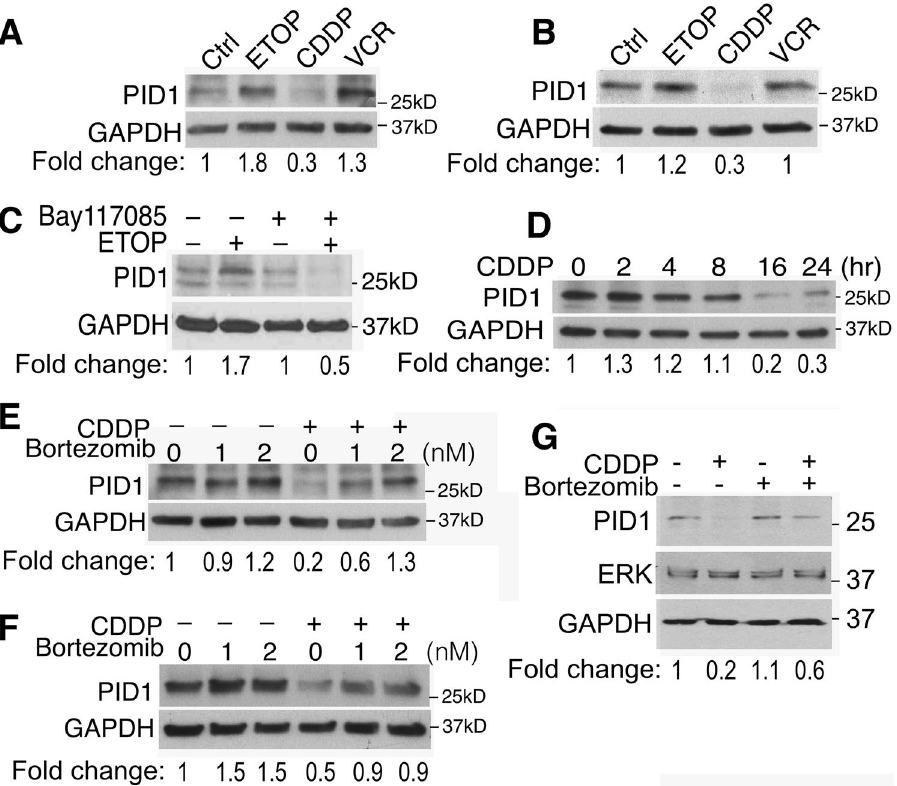
Figure 5. PID1 protein is differentially regulated by etoposide and cisplatin. SDS-PAGE and western blotting of tumor cell lysates for PID1 protein. ( A , B ) PID1 protein is increased by etoposide and vincristine but decreased by cisplatin: LN229 ( A ) or U87 ( B ) GBM cells were plated overnight in 6-well plates (4 × 10 5 cells/well). Cells were then treated with vehicle, cisplatin (5 µ g/ml; CDDP), etoposide (10 µ g/ml; ETOP), or vincristine (50 ng/ml; VCR) for 24 hrs. ( C ) Etoposide-induced increase in PID1 protein is inhibited by the NF κ B inhibitor, Bay117085: U87 cells were pre-treated with Bay117085 (2 µ M) prior to exposure to etoposide (10 µ g/ml) for 24 hr. Shown is one of two experiments with similar results. ( D ) Cisplatin decreases PID1 protein: U87 cells were treated with cisplatin (5 µ g/ml) for the times indicated. ( E , F ) Bortezomib prevents the cisplatin-induced decrease in PID1 protein: Bortezomib was added to LN229 ( E ) and U87 ( F ) GBM cells 1 hr prior to start of a 24 hr incubation with cisplatin (5 µ g/ml). ( G) ERK and GAPDH protein levels are not decreased by cisplatin while PID1 is: Bortezomib (2 nM) or vehicle were added to U87 cells 1 hr before they began 24 hr incubation with cisplatin (5 µ M). Densitometry normalized to controls in left lane is listed under the